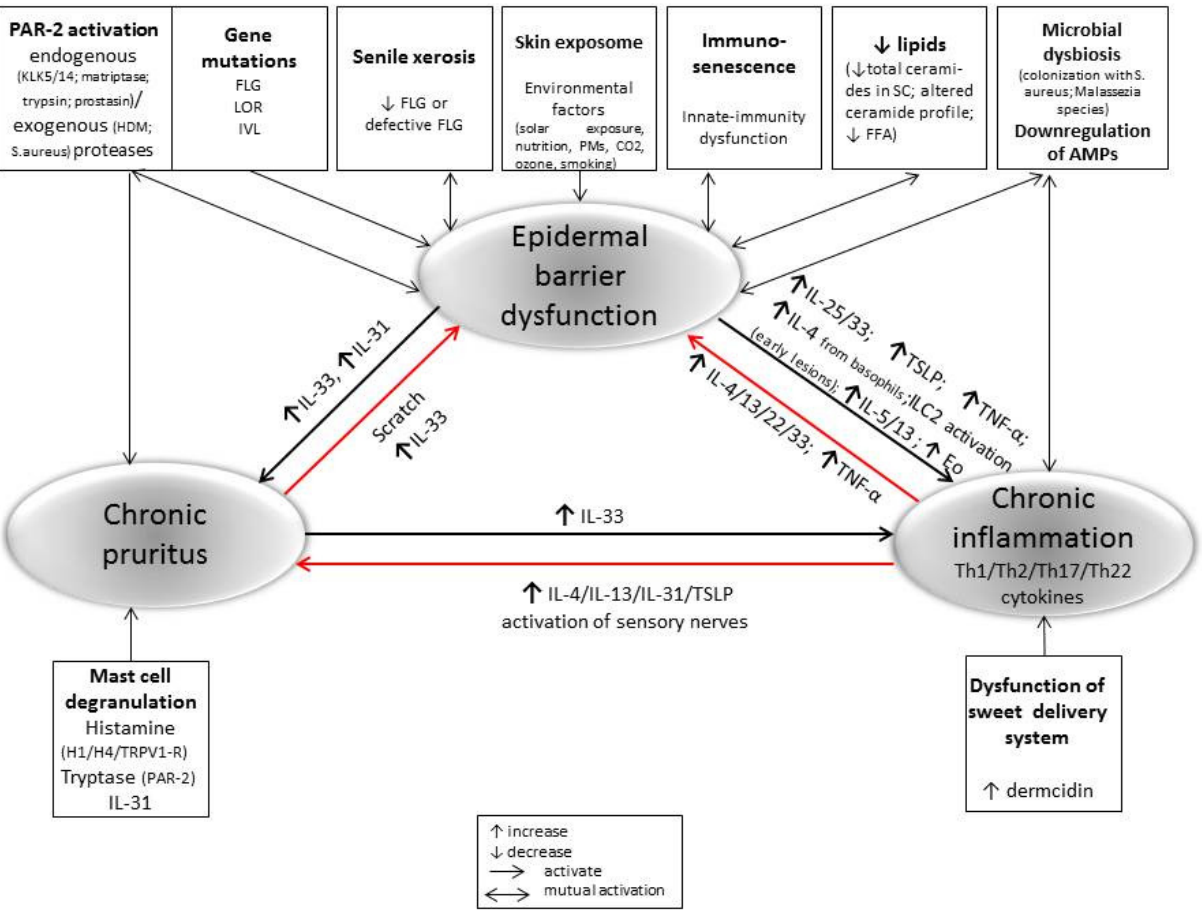
Figure 1. The crosstalk epidermal barrier dysfunction, inflammatory response, and chronic pruritus in the pathogenesis of perpetuate AD in older adults.